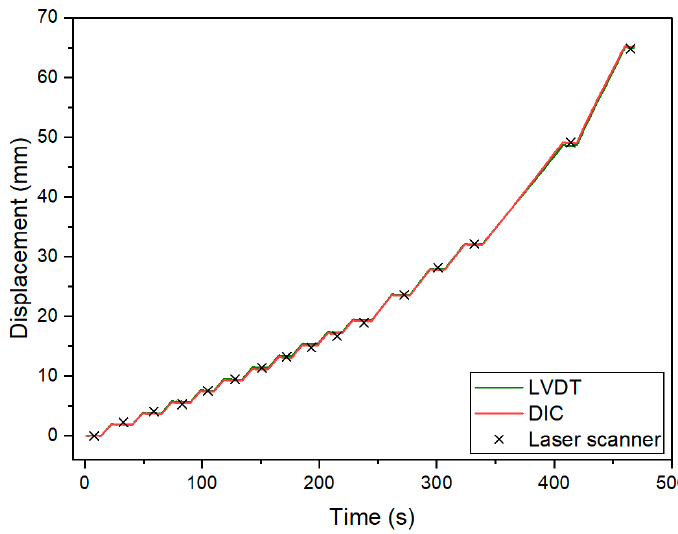
Figure 8. Comparison of the results of vertical displacements in the α‐α section.